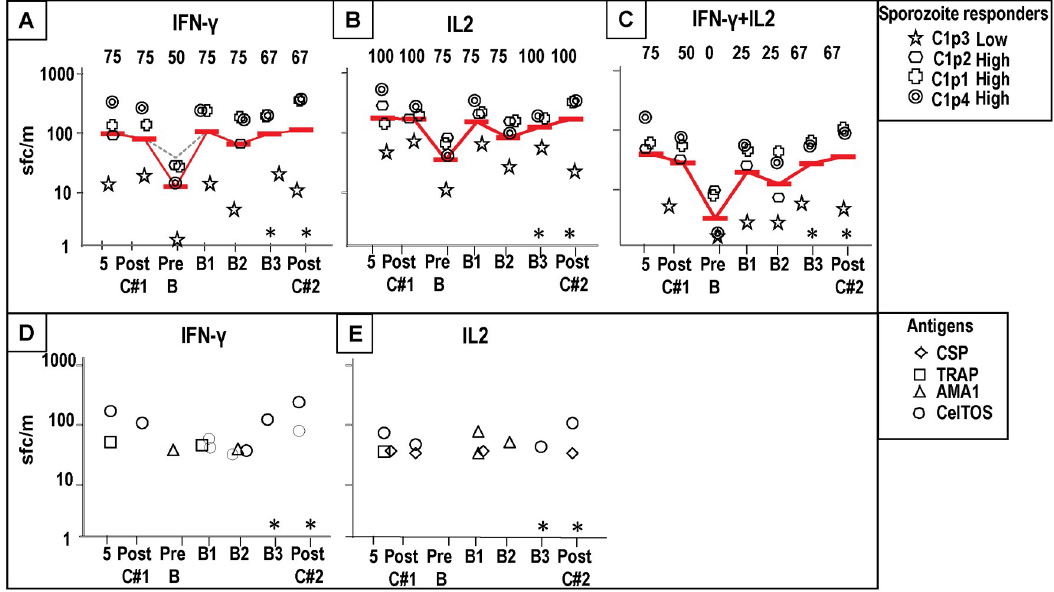
Fig 8. Cohort 1 hyperimmunized subjects: IFN- γ , IL2 and IFN- γ +IL2 responses to sporozoites, CSP, AMA1, TRAP and CelTOS. IFN- γ , IL2 and IFN- γ +IL2 responses of four subjects protected to CHMI#1 were measured after post-5 th (5) immunization, 39–41 days post-CHMI#1 (Post-C#1), 27 weeks post-CHMI#1/pre-boost (PreB), post-1 st boost (B1), post-2 nd boost (B2), post-3 rd boost (B3) and 15 weeks post-CHMI#2 (Post-C#2). Responses to sporozoites: three high responders (C1p1 stars; C1p2 rounded squares; C1p4 crosses) and one low responder (C1p3 double circles); geometric mean of sporozoite responses (red bar); numbers at top of Panel are % positive subjects. � Only 3 subjects (C1p2; C1p3, C1p4) were tested at these time points. Panel A: IFN- γ responses: sporozoites : IFN- γ responses declined by 27 weeks after CHMI#1/pre-boost but rose post-1 st boost and were then largely unchanged. Panel B: IL2 responses: sporozoites : IL2 responses followed the same pattern as IFN- γ responses. Panel C: IFN- γ +IL2 responses: sporozoites : IFN- γ +IL2 responses disappeared by 27 weeks after CHMI#1/pre-boost, and slowly rose post-1 st , and post- 3 rd boosts and post-CHMI#2. Responses to antigens: CSP (diamonds), AMA1 (triangles), TRAP (squares) and CelTOS (circles). Panel D: IFN- γ : only one subject (C1p3) had a positive IFN- γ response to AMA1 by 27 weeks post-CHMI#1/pre-1 st boost; post-1 st boost and post-2 nd boost IFN- γ responses to individual antigens rose. Panel E: IL2 : no subjects had IL2 responses to any antigen